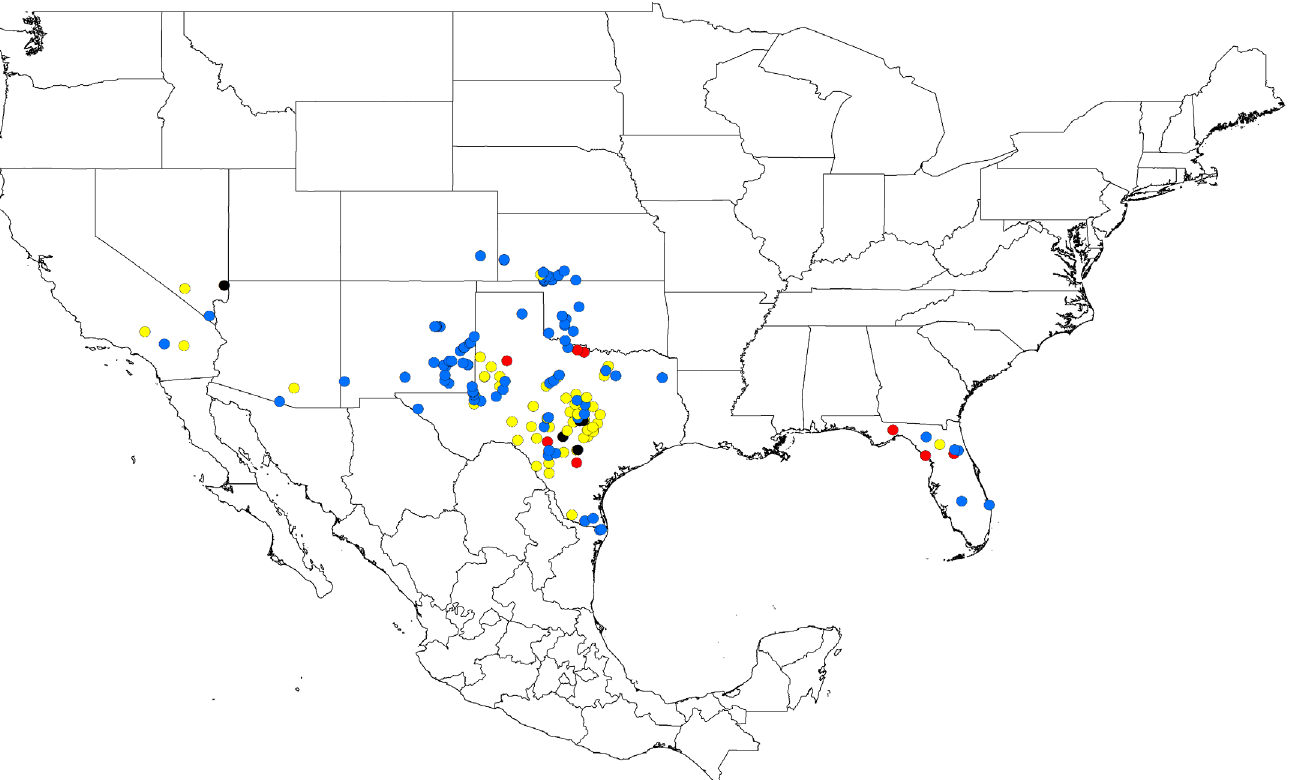
Fig 1. Ornithodoros turicata localities generated from USNTC and SCAN reports, literature reviews, and field studies. Localities in which a collection date was not recorded are represented by black circles. Blue, yellow, and red circles represent localities that were collected from 1800 – 1950, 1950 – 2000, and 2000-present, respectively.